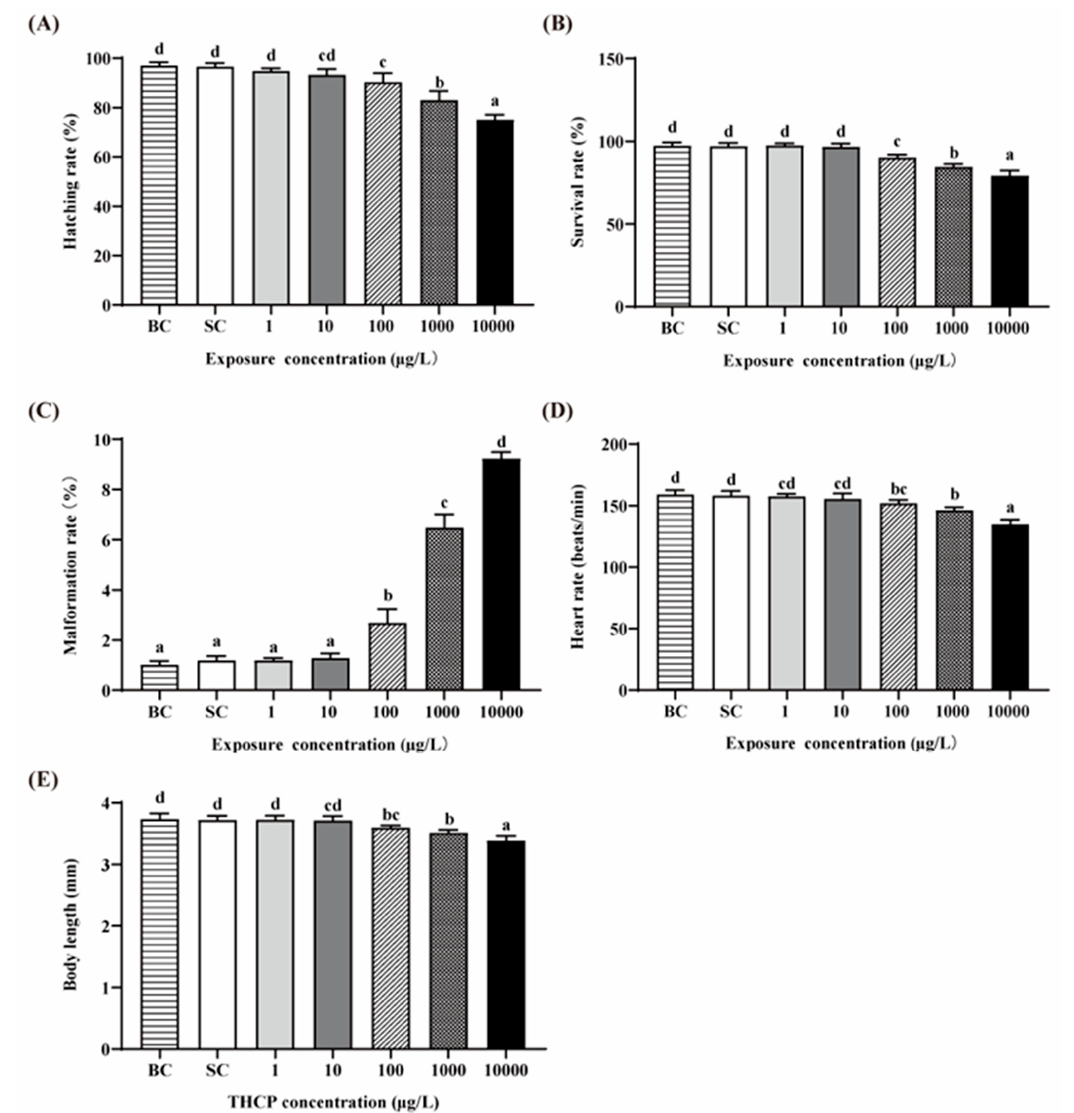
Figure 1. Effects of THCP on zebrafish larvae in different stages. ( A ) Hatching rate, ( B ) survival rate, ( C ) malformation rate, ( D ) heart rate and ( E ) body length of zebrafish. One-way ANOVA followed by Tukey’s post hoc tests was used to determine statistical differences. Different letters indicate significant differences between different treatment groups ( p < 0.05).